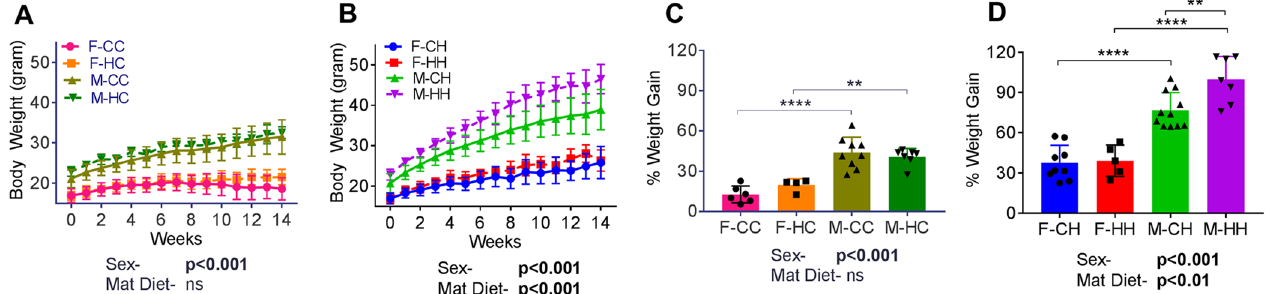
Figure 1. Body weights and weight gain in male and female offspring of control and HFD-fed dams. ( A ) Body weights of male and female offspring born to control (Con) and HFD-fed dams weaned onto Con (F-CC, F-HC, M-CC, and M-HC, n = 4–10) or ( B ) HFD (F-CH, F-HH, M-CH, and M-HH, n = 5–11) for 14-week following weaning. Overall weight gain at the end of the study in male and female offspring from Con and HFD-fed dams fed ( C ) control and ( D ) on high-fat diet. Data are expressed as means ± SD. Statistical differences between groups were determined using a 2-way ANOVA to examine the effects of maternal HFD and sex of the offspring, followed by Student-Newman-Keuls post hoc analyses. ( * p < 0.05, ** p < 0.01 *** p < 0.001, **** p < 0.0001).